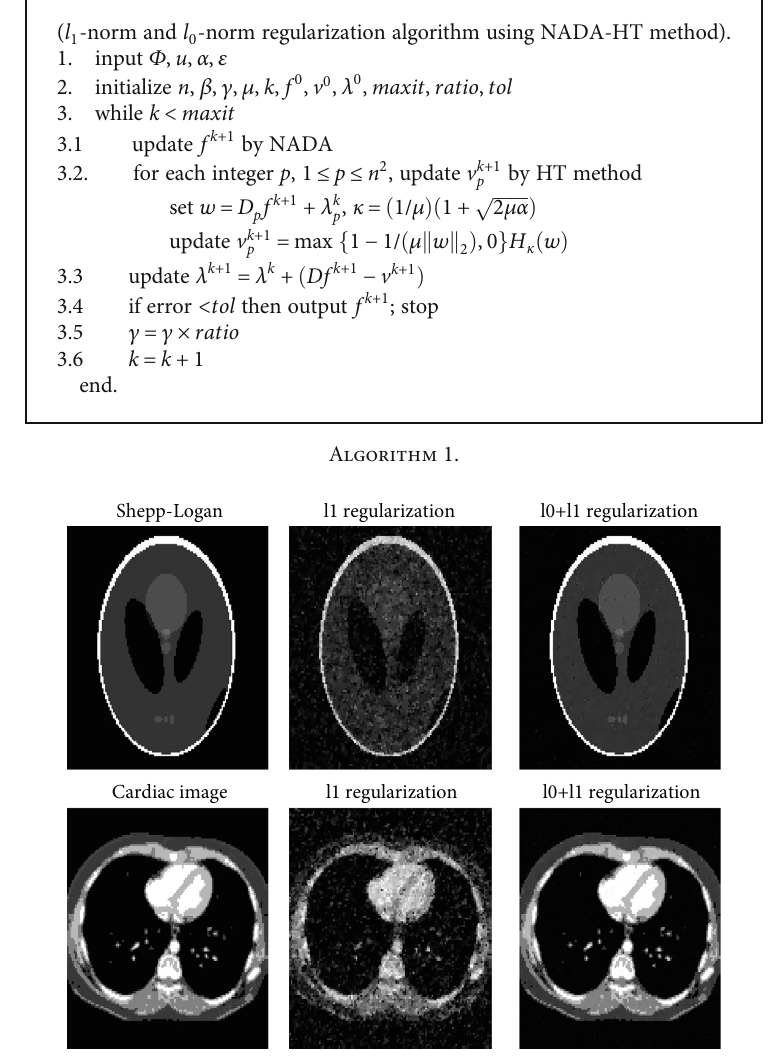
Figure 1: Original and reconstructed images. First row: Shepp-Logan phantom after 200 iterations. Second row: cardiac image after 500